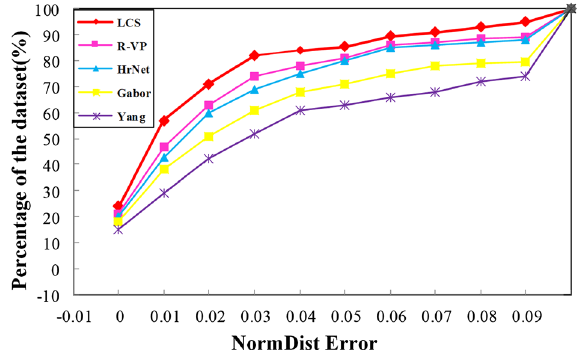
Figure 6. The performance VS normal distance error of different methods.